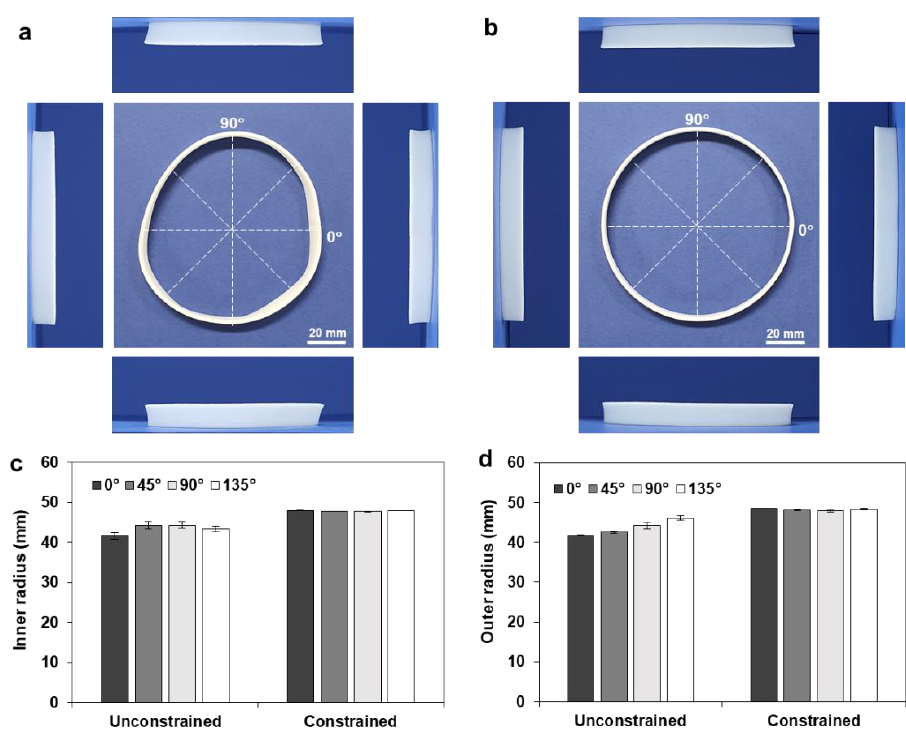
Figure 8. Comparison of the roundness of the deformed annulus ( r o = 60, w = 10 mm): ( a ) unconstrained deformation; ( b ) constrained deformation; ( c ) comparison of the inner radius ( r i *); ( d ) comparison of the outer radius ( r o *).